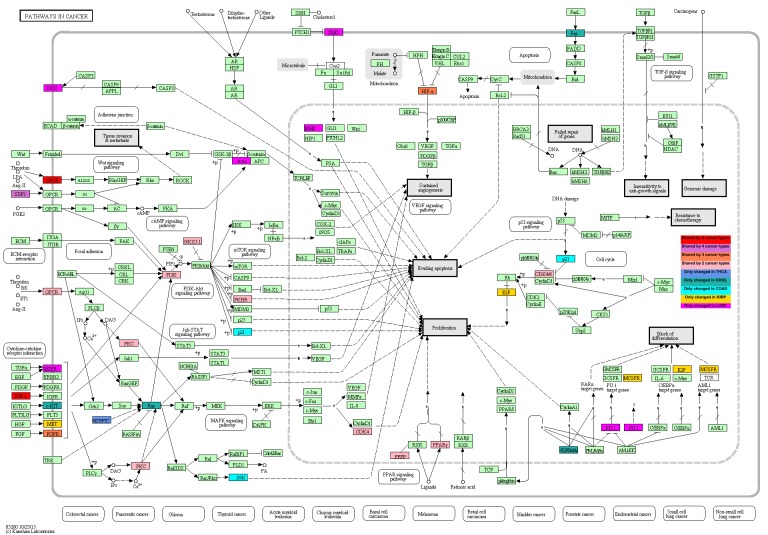
A general picture showing affected genes in KEGG: Pathways in Cancer.The genes are color-coded according to the number or cancer types among which they are shared. Red indicates sharing by 5 cancer types; orchid indicates sharing by 4 cancer types; coral indicates sharing by 3 cancer types; and light pink indicates sharing by 2 cancer types. In contrast, the genes that were affected only in a single cancer type are represented with the following colors: only THCA, cornflower blue; only CHOL, light sea green; only COAD, cyan; only KIRP, gold; and only LUSC, magenta. Unfortunately, there were no genes that were specific to LIHC.